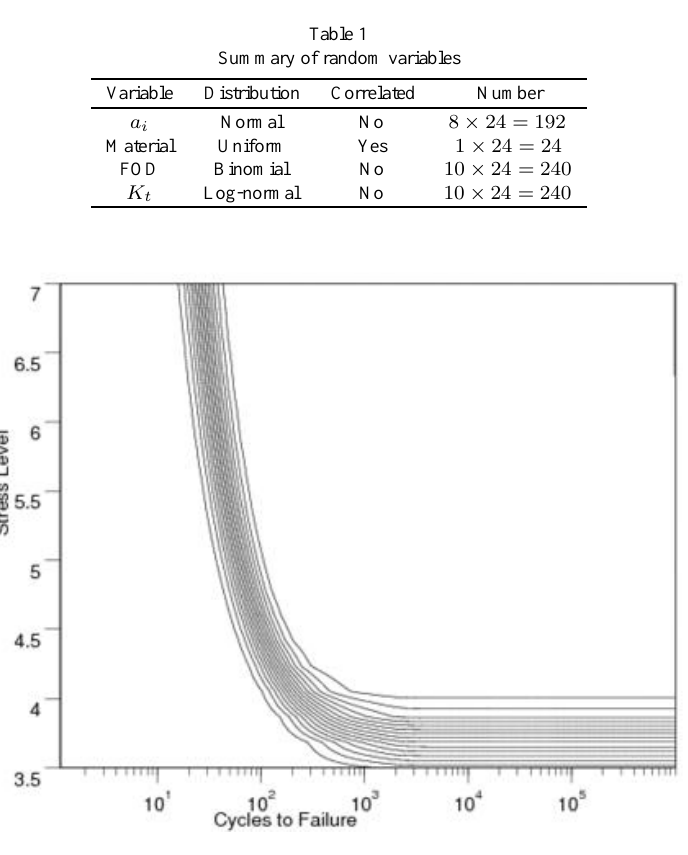
Fig. 9. Random fatigue limit